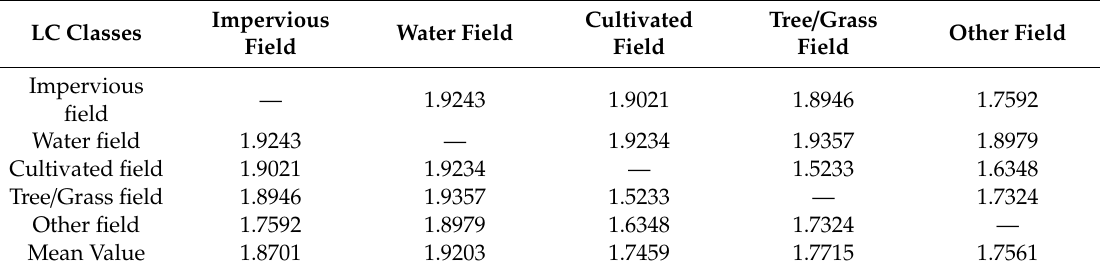
Table 5. The mean values of Je ff ries–Matusita ( J-M ) distance between the features of two LC classes of automatically collected